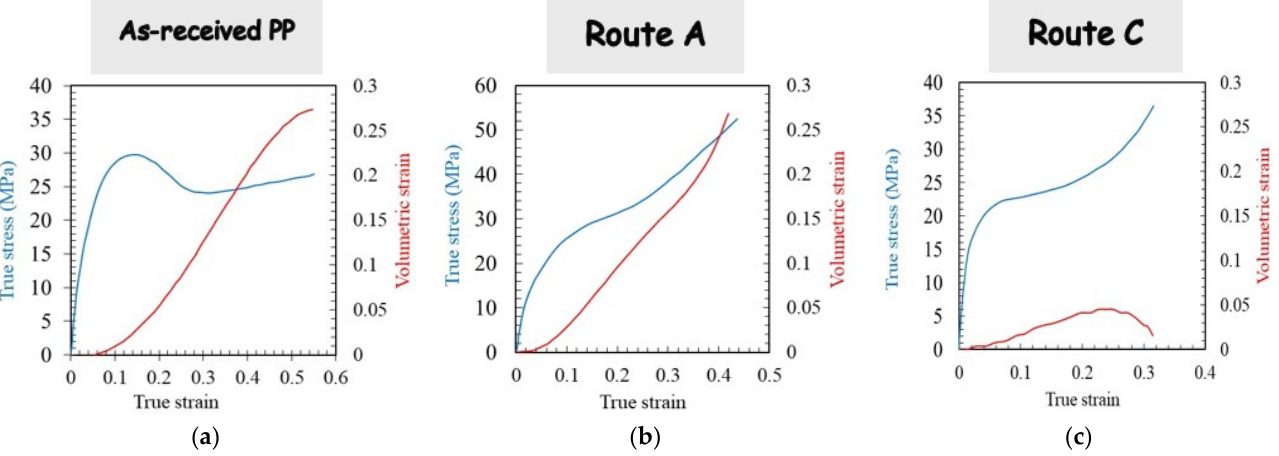
Figure 11. Tensile results in terms of stress and volumetric strain of ( a ) as-received material and after second pass extrusion ( b ) in route A and ( c ) in route C (ram velocity of 4.5 mm/min and BP of 0 N).